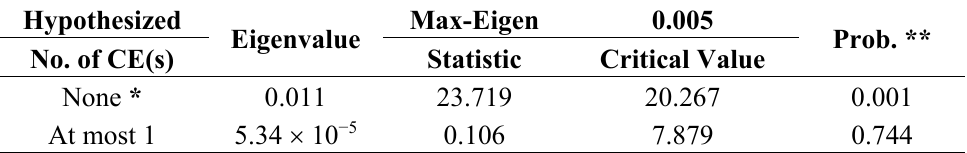
Table 2. Unrestricted Cointegration Rank Test (Maximum